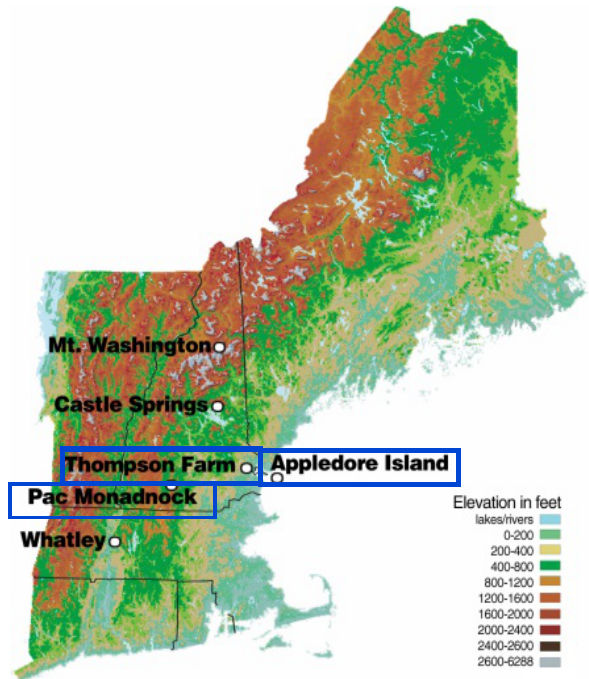
Fig. 1. Locations of the AIRMAP air quality monitoring stations. Figure 1. Locations of the AIRMAP air Thompson Farm, Pac Monadnock, and Appledore Island are high- quality monitoring stations. lighted in blue Island are highlighted in blue boxes.